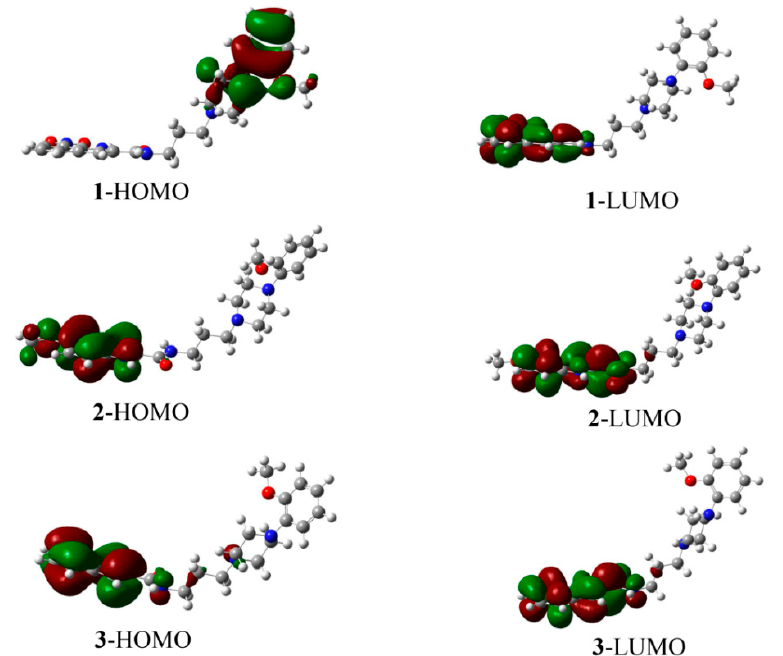
Figure 9. HOMO, LUMO surfaces of compound 1 , 2 and 3 simulated at the B3LYP/6-311G (d, p) level of theory. Table 7. Frontier molecular orbital energies of 1 , 2 and 3 (eV).